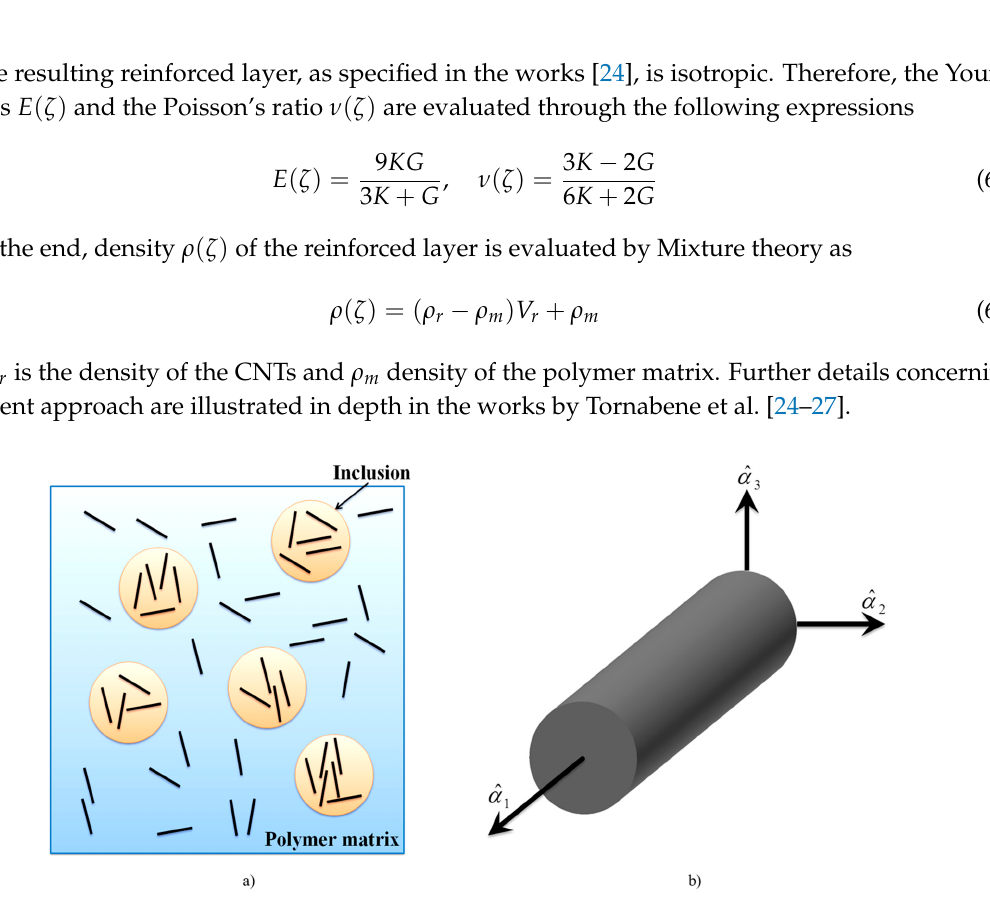
Figure 3. CNT reinforced composite layer: ( a ) shell element with inclusion model of CNT agglomeration; ( b ) effective CNT fiber and local co-ordinate system representation. Table 1. Hill’s elastic moduli for several Single-Walled Carbon Nanotubes. Carbon